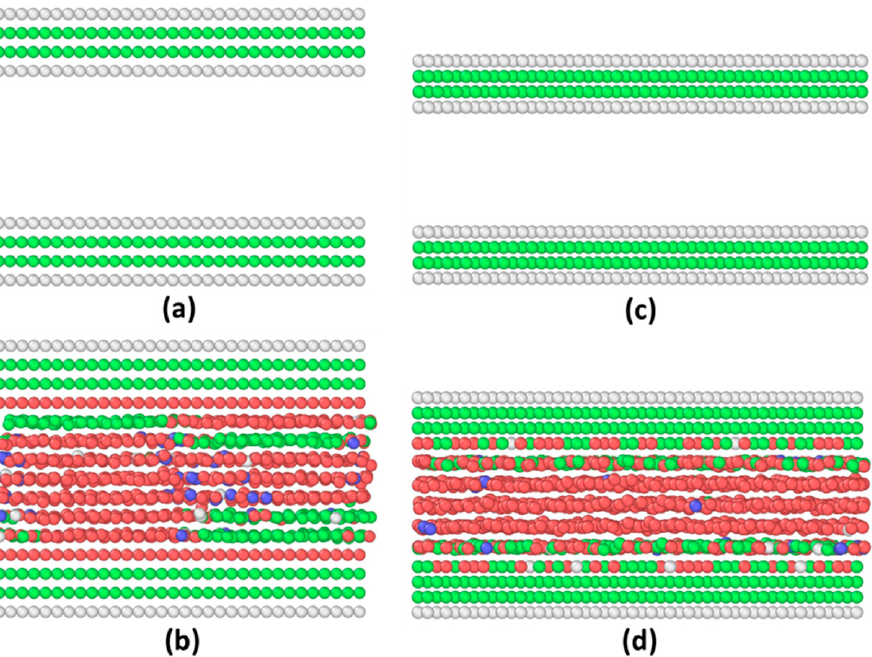
Table 1. For both contacts, the wall–fluid interaction between argon and solid wall is the same as the argon–argon interaction (i.e., ε wf = ε ff = ε , where w and f stand for “wall” and “fluid,” respectively).